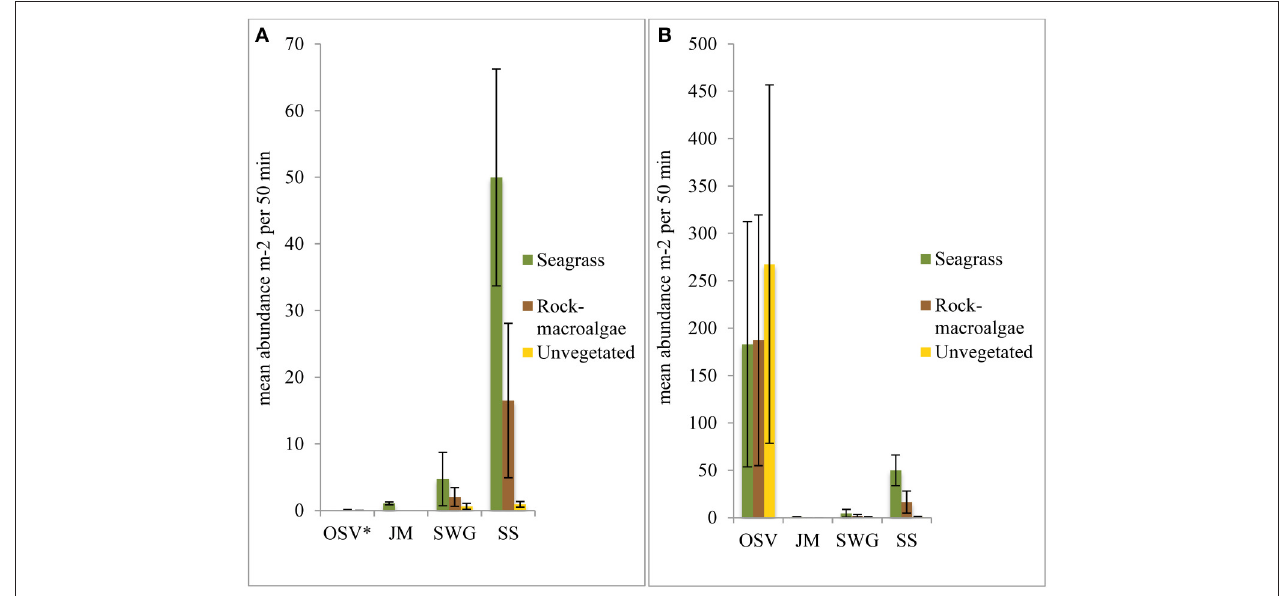
FIGURE 4 | Mean fish abundance per m 2 over the 50min sampling period for each habitat preference guild (OSV—occasional shallow-water visitors, JM—juvenile migrants, SWG—shallow-water generalists, SS—stationary species) per habitat. The figure on the left (A) excludes C. harengus in the OSV guild (indicated by *),